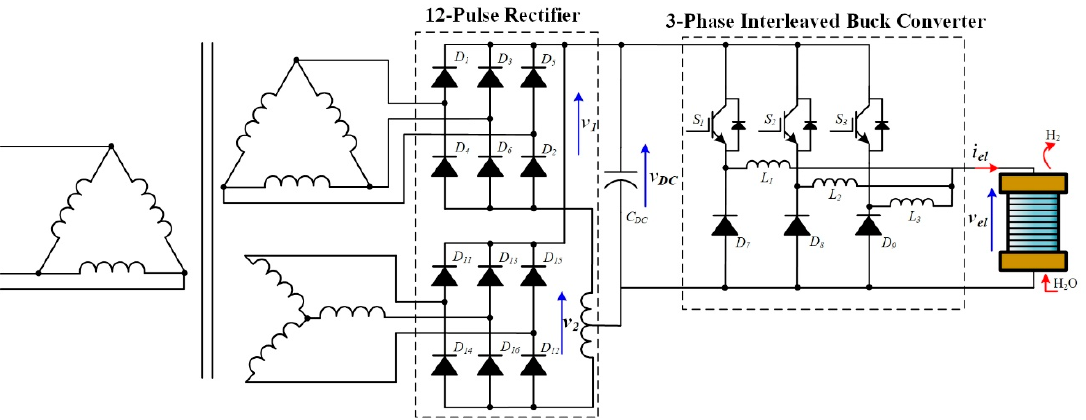
Figure 14. 12-pulse diode bridge rectifier with a three-phase interleaved buck converter.